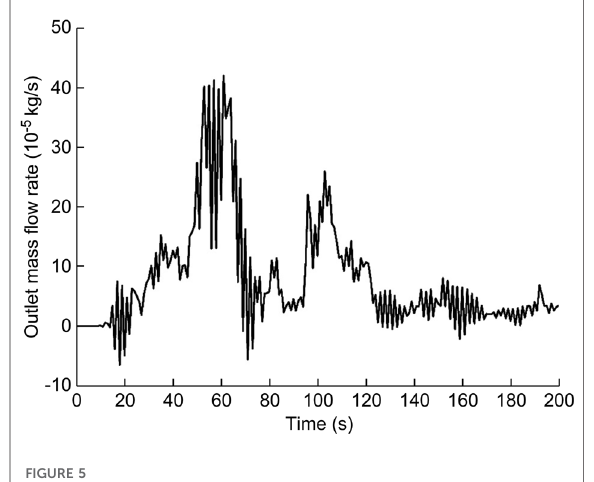
FIGURE 5 The outlet mass fl ow rate monitoring graph of the straight model of the spindle incision.